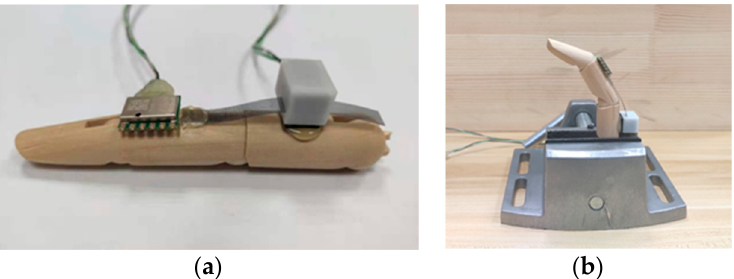
Figure 15. Calibration experiment platform. ( a ) Wooden finger model with a sensing unit and a gyroscope; ( b ) Wooden finger on the flat tongs.